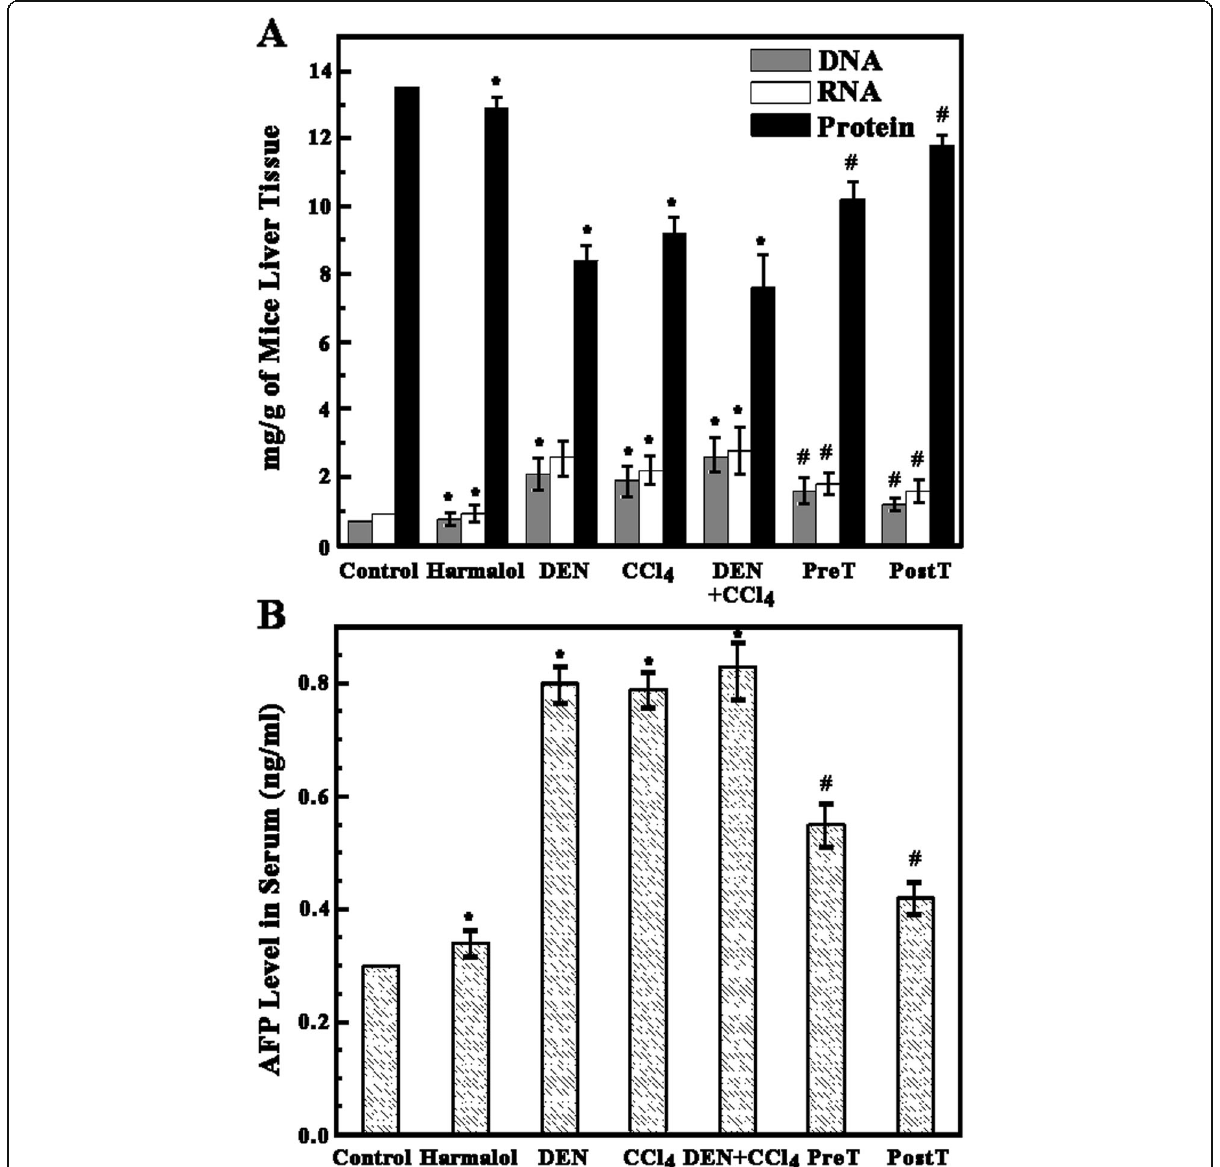
Fig. 5 a Bar graph representation showing the estimation of hepatic DNA, RNA, and normal serum protein level in seven different experimental groups. b Bar graph representation of the alpha-fetoprotein level in serum of seven different experimental groups. Data are presented as mean ± SE, * P < 0.001 compared with the control group; # P < 0.001 compared with the DEN+CCl 4 -treated